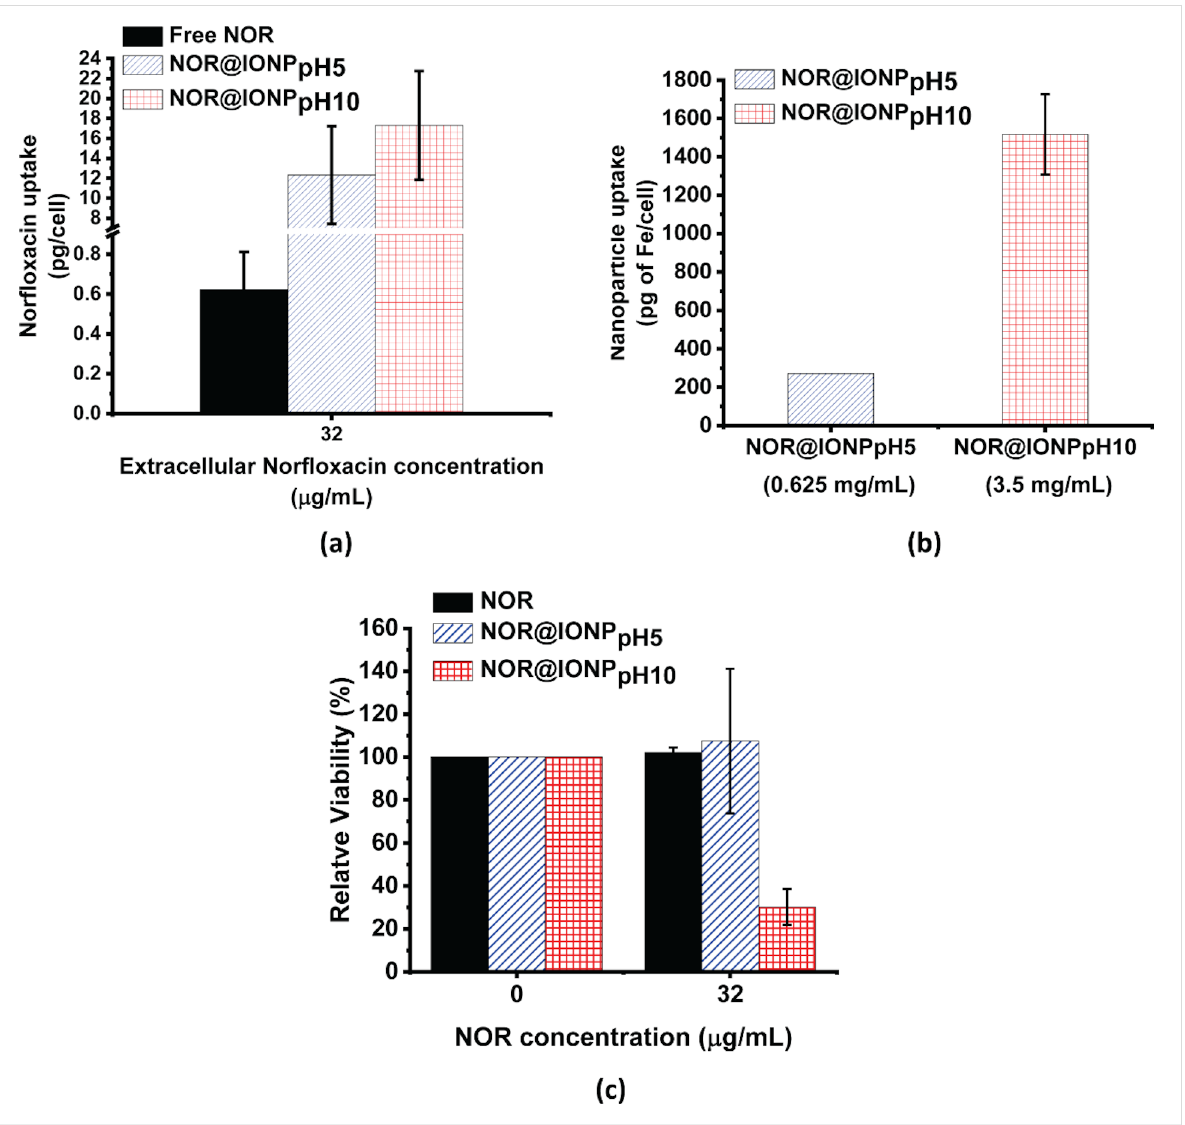
Figure 6: (a) NOR uptake in macrophage cells after 48 h treatment with NOR, extracellular concentration of 32 µg/mL. (b) Nanoparticle uptake esti- mated in terms of the uptake of Fe (pg/cell). (c) Relative viability of differentiated THP1 cells after treatment with 32 µg/mL of NOR over 48 h. The black columns depict free drug treatment, blue diagonal patterned columns depict treatment via NOR@IONP pH5 and red checked columns depict treatment with NOR@IONP pH10 . Statistical significance was estimated using the student’s t -test where “***” represents α ≤ 0.001. All data is plotted as the mean and standard deviation of 3 biological